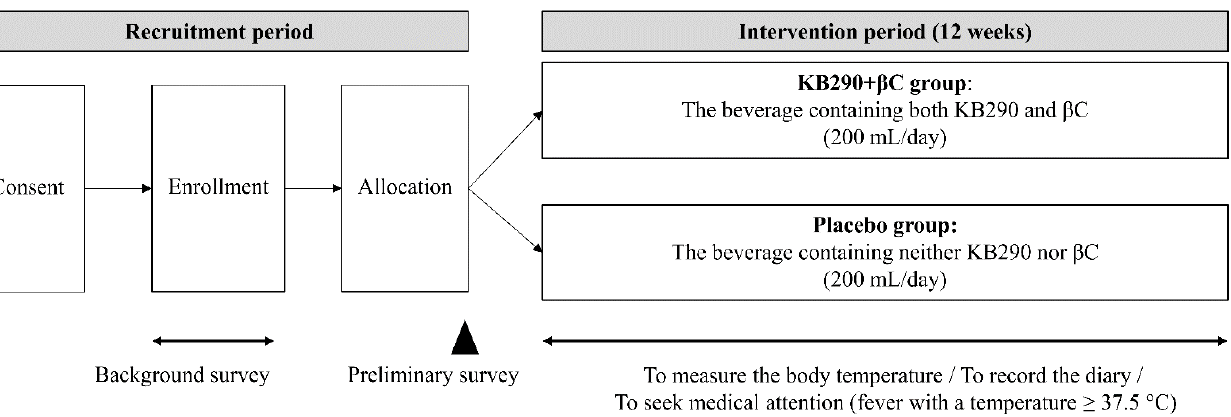
Figure 1. Trial design.